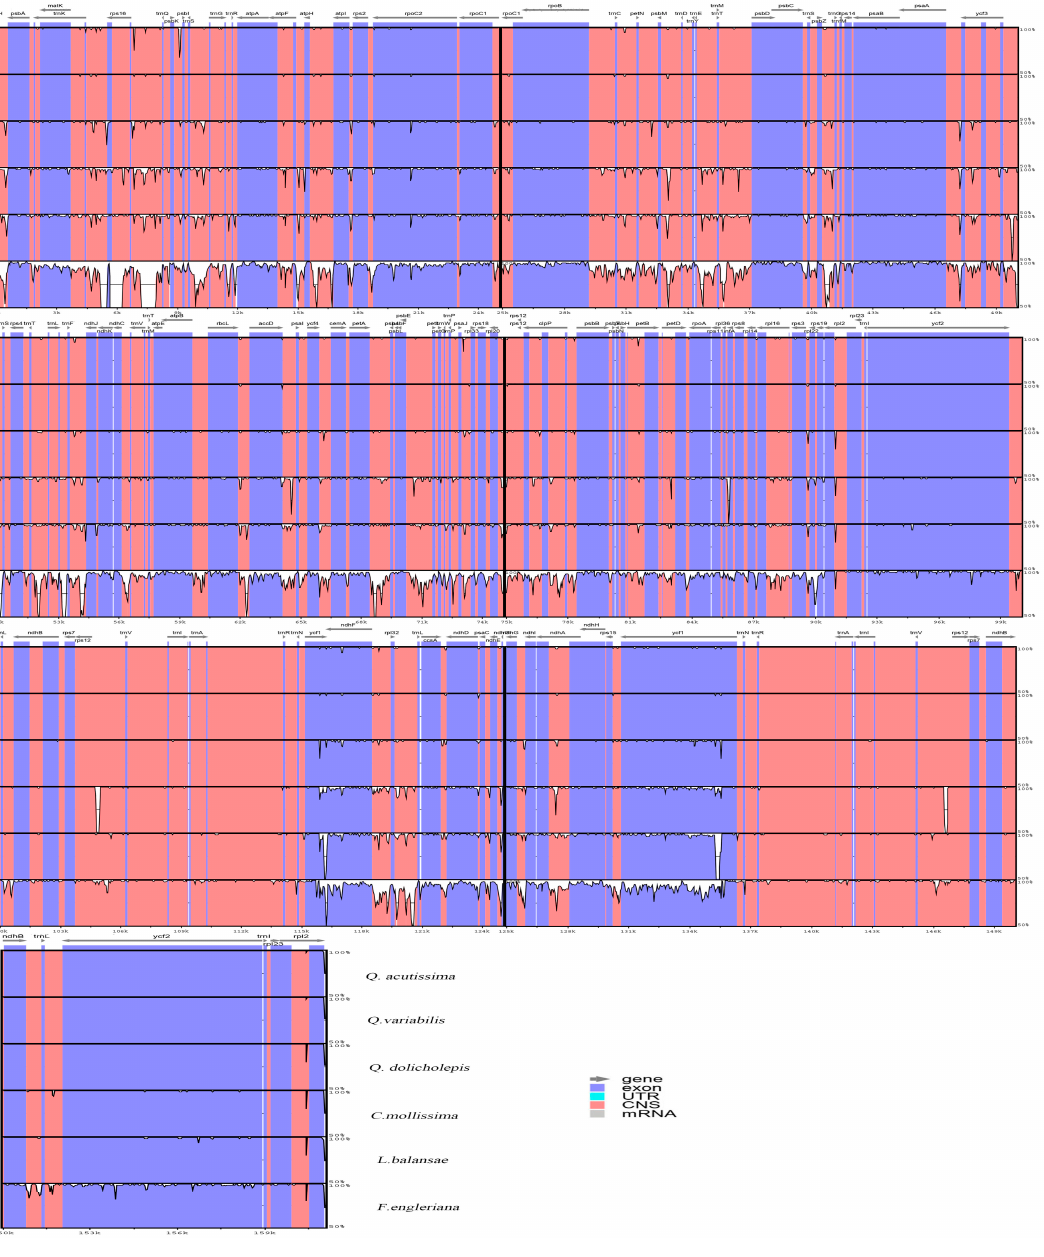
Figure 2. Complete chloroplast genome comparison of six species using the chloroplast genome of Q. variabilis as a reference. The grey arrows and thick black lines above the alignment indicate the genes’ orientations. The Y-axis represents the identity from 50% to 100%.